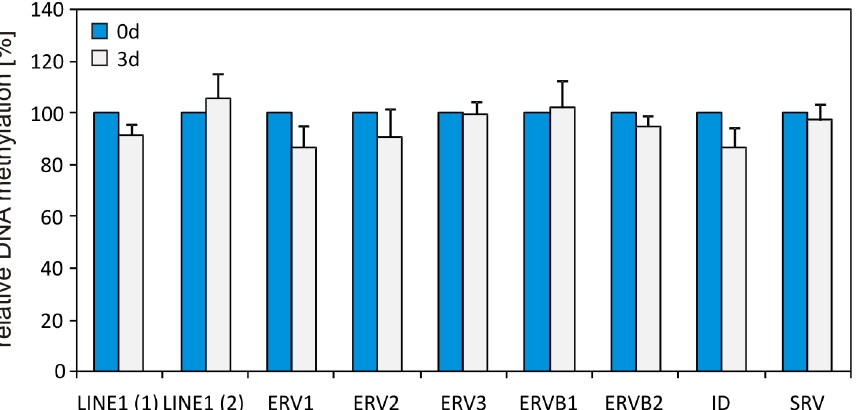
Fig 4. DNA methylation analysis in repetitive DNA elements. The DNA methylation was measured within consensus sequences of different repetitive elements by qAMP (n = 5). DNA methylation of freshly isolated HSC (0d) was set to 100%. There were no significant changes in the DNA methylation level between freshly isolated and 3d cultured HSC